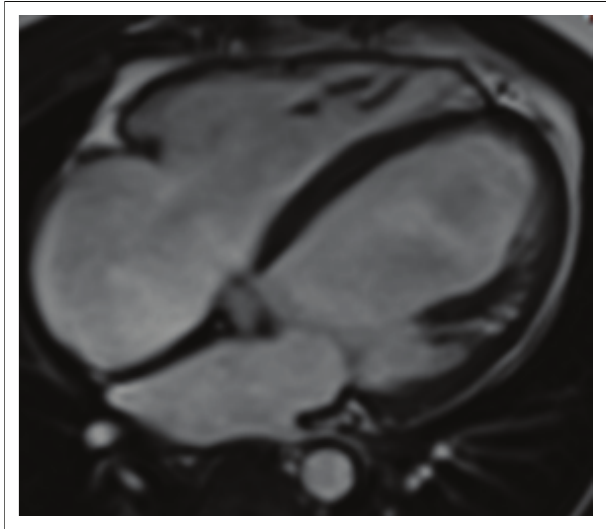
FIGURE 1: Dilated cardiomyopathy. Cine b-SSFP in end-diastole demonstrates enlarged LV volumes with the end-diastolic diameter 67 mm. The end-systolic diameter was 58 mm.